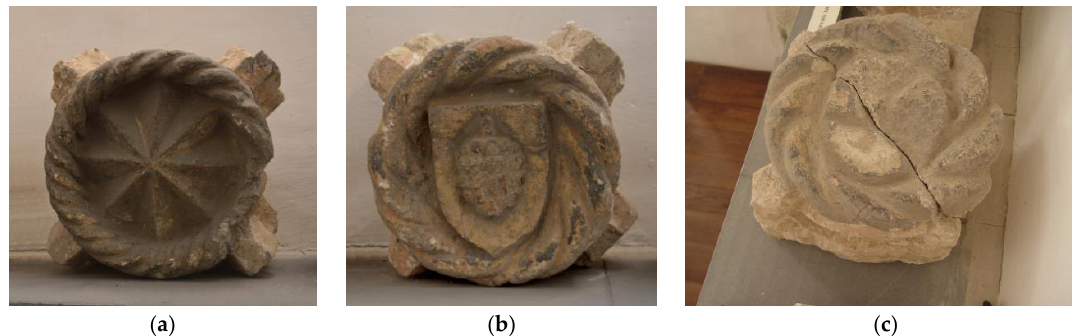
Figure 19. Maribor Synagogue, three keystones with an outset of perpendicular crossed ribs, belonging to the second phase of the building: ( a ) a keystone, decorated with an eight pointed star, ( b ) a keystone with a motif of a grape on a pointed shield, encircled by a coil consisting of two intertwining girdles, ( c ) a keystone, decorated by a turban girdle made of rounded belts. Photo Janez Premk. When the synagogue was turned towards the east, a new Torah Ark location had to be found.